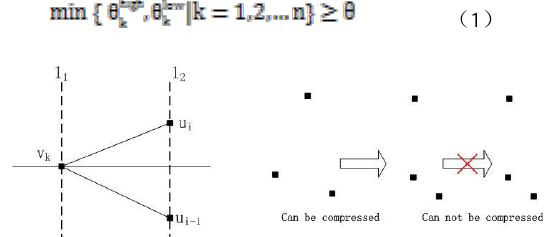
Figure 7. A cartogram algorithm for point features